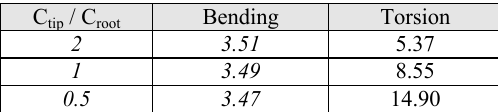
Table 1. Coefficients λ n for isotropic materials